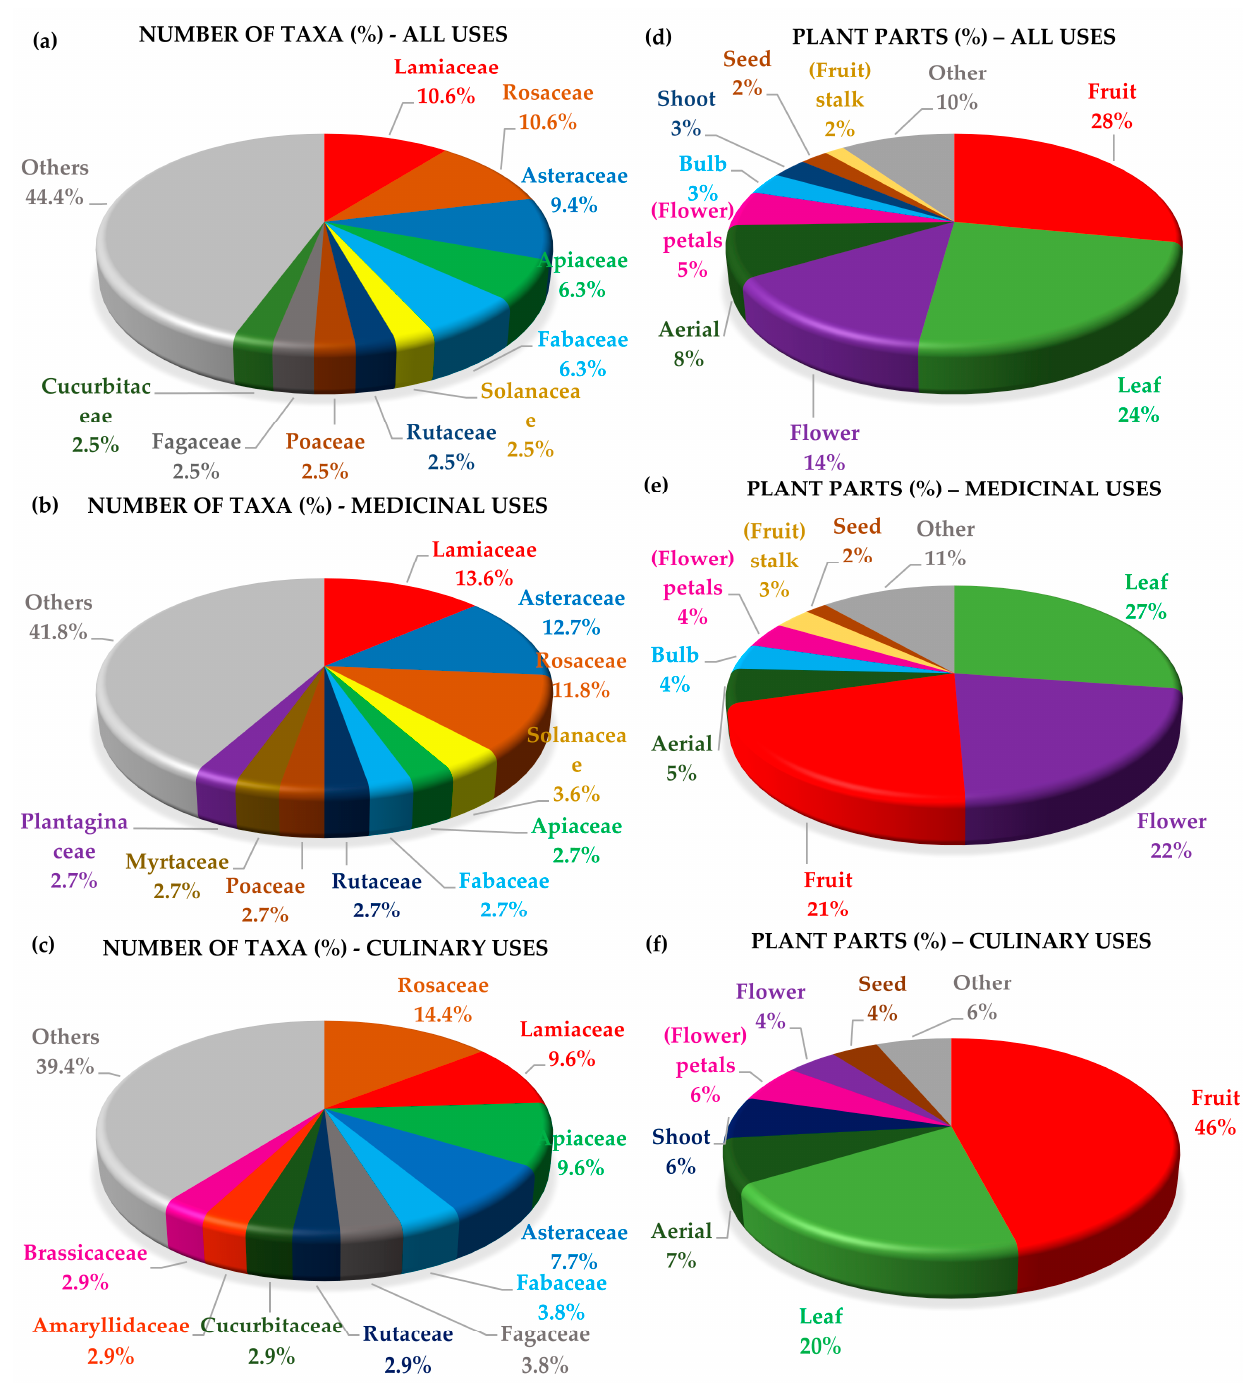
Figure 4. The percentage of reported taxa per plant family across all uses ( a ), with respect to medicinal uses ( b ), and culinary uses ( c ). The percentage of reported used plant parts across all uses ( d ), with respect to medicinal ( e ) and culinary uses ( f ).